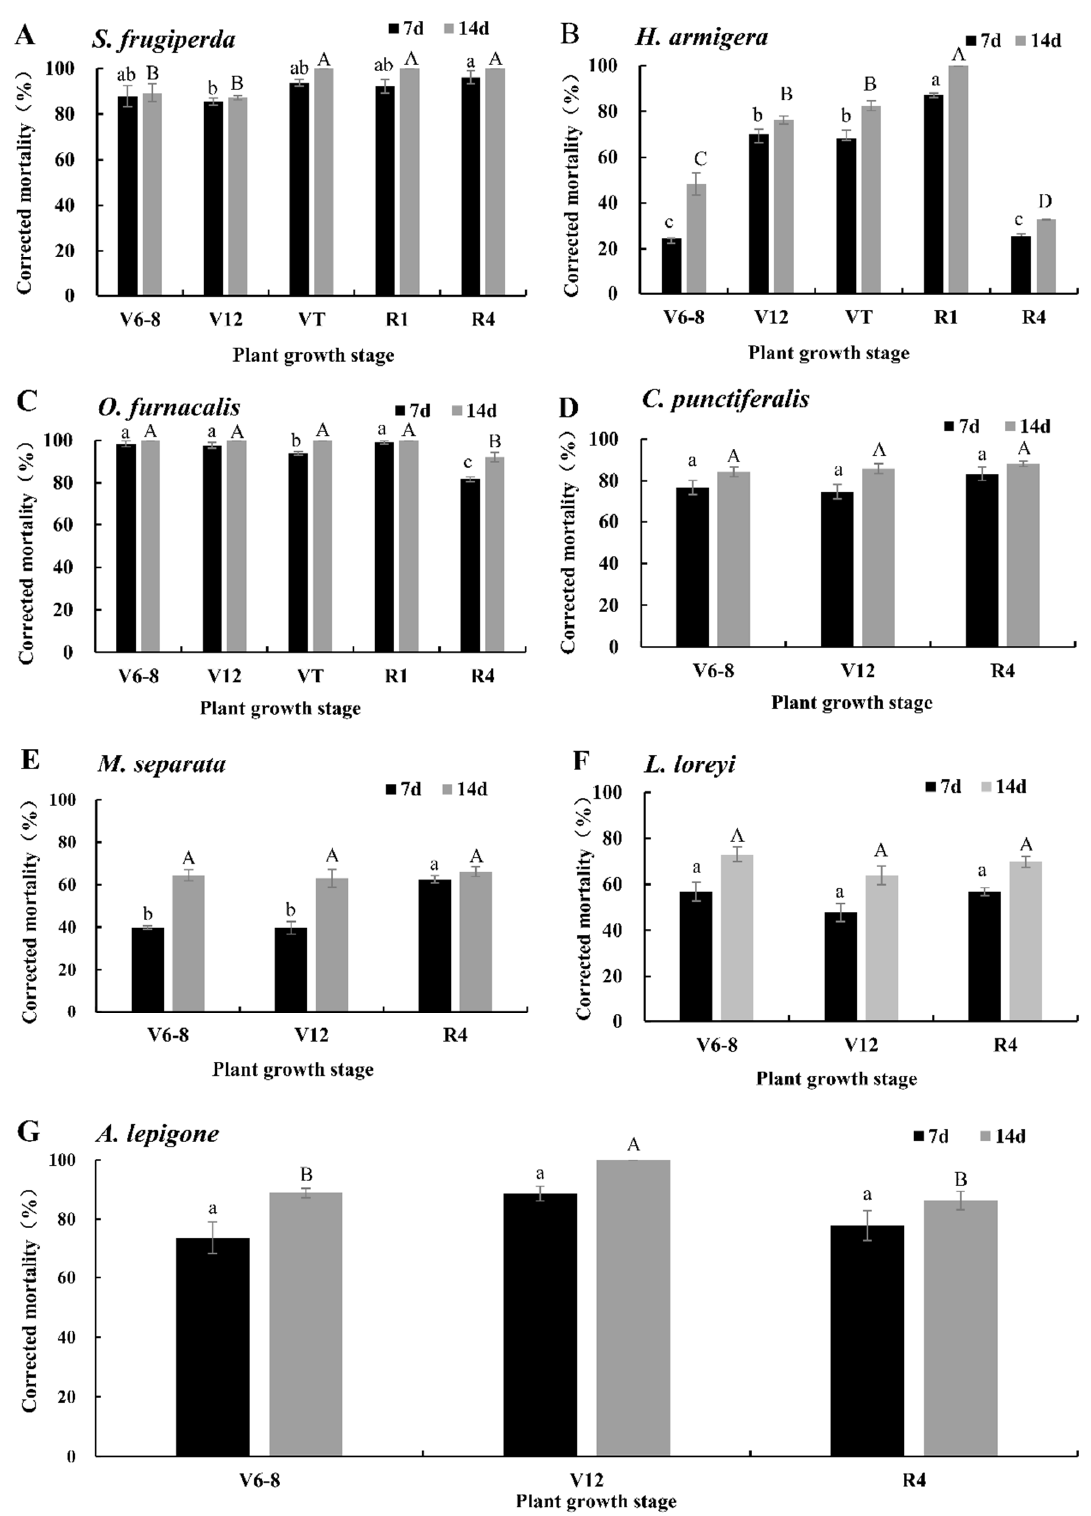
Figure 2. Corrected mortalities of neonates for seven lepidopteran pests on artificial diet containing lyophilized different tissues of DBN9936 × DBN9501 corn (expressing Cry1Ab and Vip3Aa) in different growth stages at a 25-fold dilution relative to the isogenic negative control. Values represent means ± SE. Different lowercase and uppercase letters above black and gray bars indicate significant difference for the same treatment time by Duncan’s multiple range test ( p < 0.05). ( A ) S. frugiperda ; ( B ) H. armigera ; ( C ) O. furnacalis ; ( D ) C. punctiferalis ; ( E ) M. separata ; ( F ) L. loreyi ; and ( G ) A. lepigone